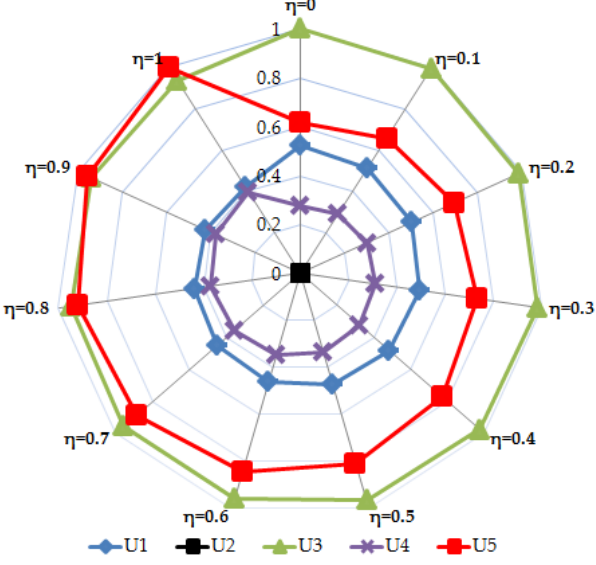
Figure 9. Parameter sensitivity analysis for η